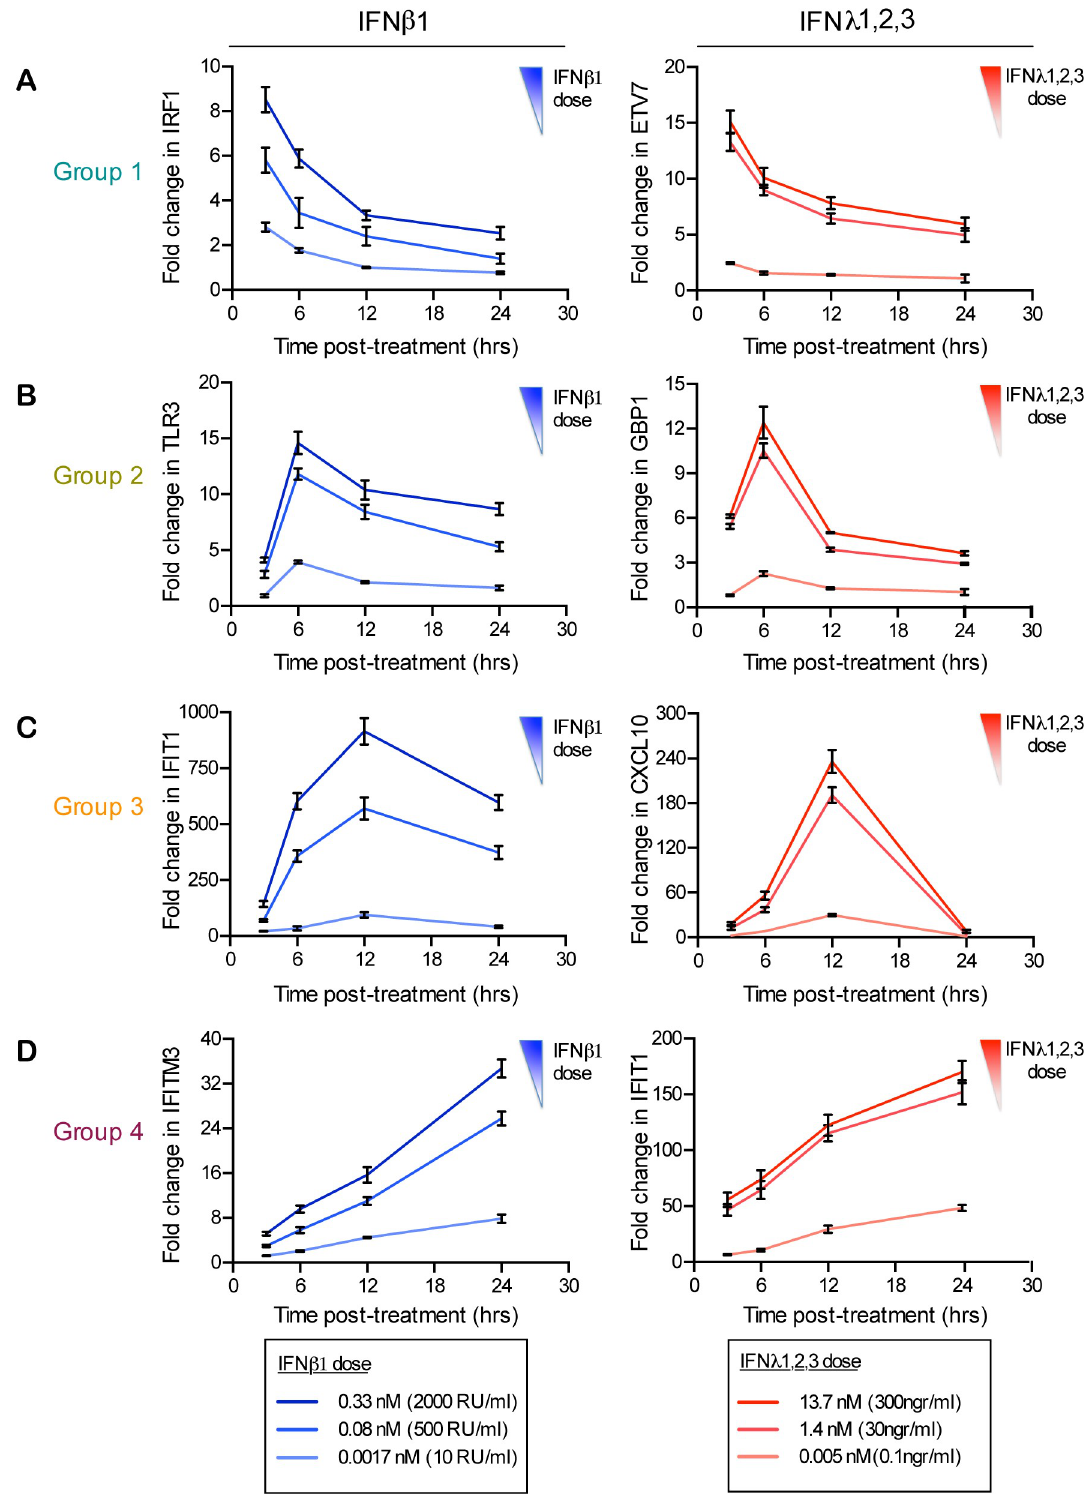
Fig 4. Validation of the unique kinetic patterns of ISG expression upon type I versus type III IFN treatment. (A-D) Human colon organoids were stimulated with increasing concentrations of type I IFN ( β ) or III IFN ( λ 1 − 3) for indicated times and the kinetic pattern of expression of one representative ISG from each temporal expression patterns groups 1–4 was analyzed by qRT-PCR, (left